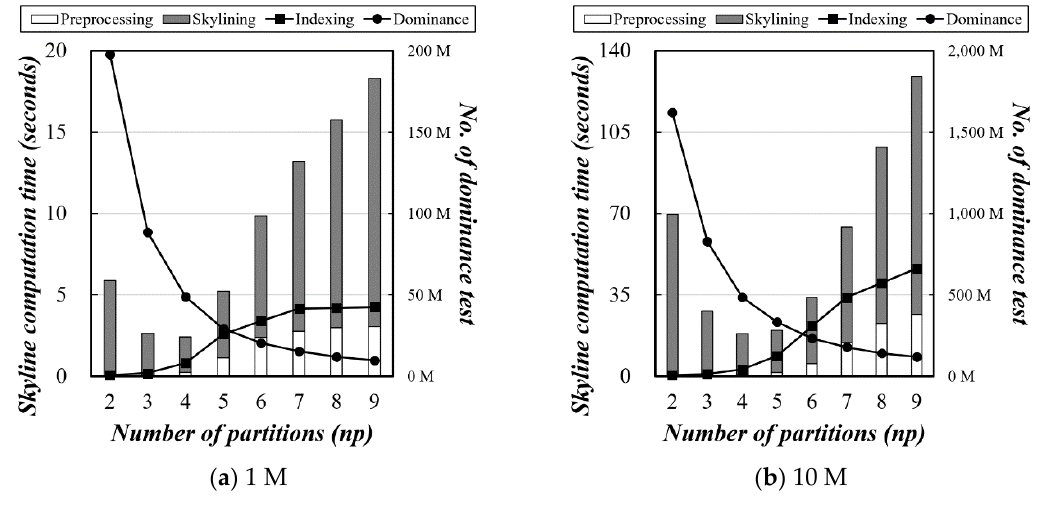
Figure 5. The performance changes according to varying np.